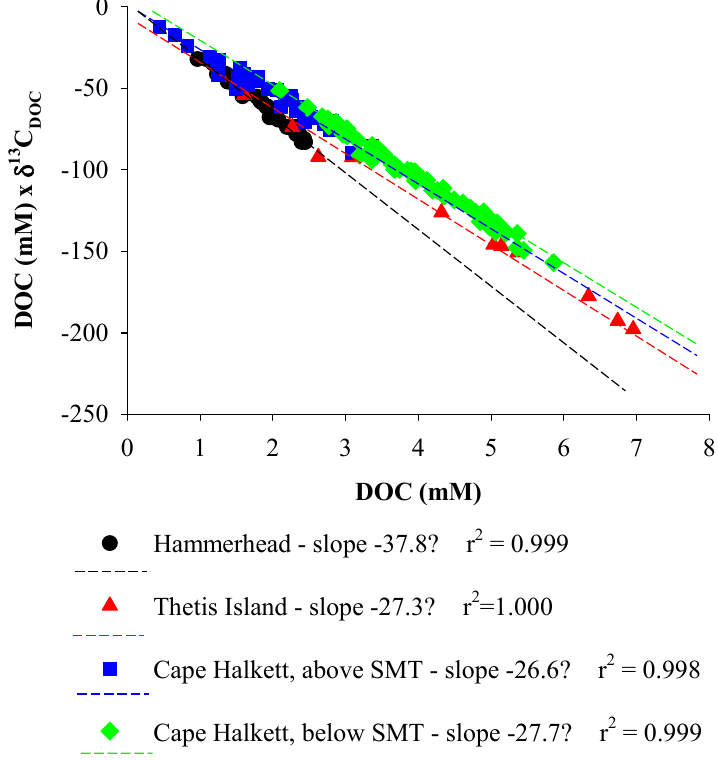
Figure 7. Plot of measured δ 13 C DOC × DOC concentrations vs. DOC concentrations in sediment cores collected along the North Slope of Alaska on the Beaufort Sea. Data are grouped into four data sets: Hammerhead Nearshore and Offshore; Thetis Island; Cape Halkett above and below the SMT (Figure 1). The slope of the linear fit to each data set is presented below the plot (Equation (4)).